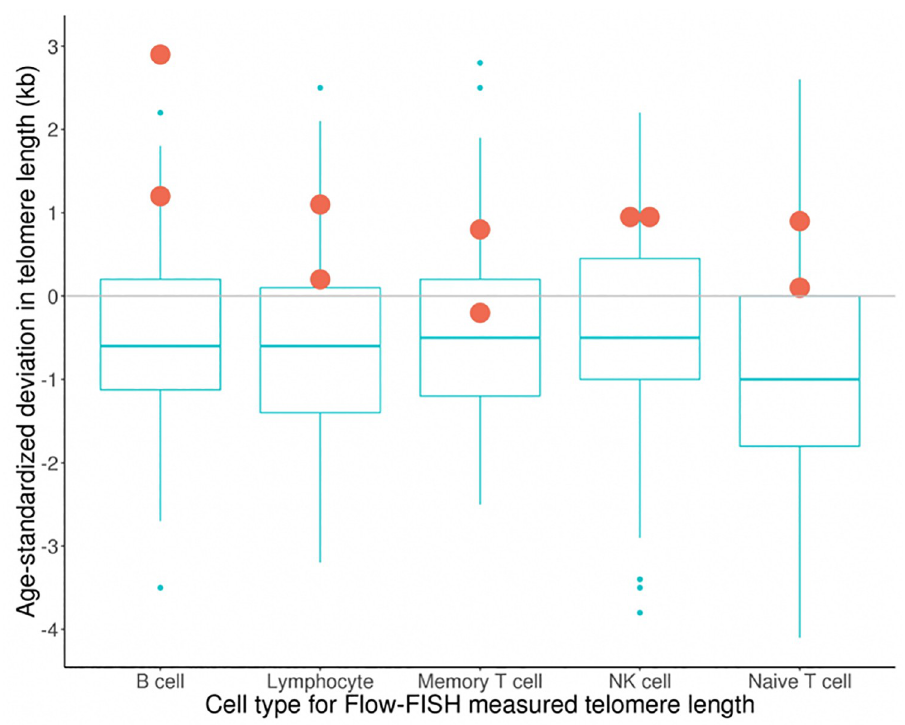
Fig 1. Deviation from the age-based mean leukocyte telomere length measured by flow-FISH in survivors of childhood cancer. Two of these survivors (one CEU and one YRI) were heterozygous for the high risk POT1 rs58722976-G allele (denoted by circles) and demonstrate telomere length that is above the median for all leukocyte subsets and significantly longer among B lymphocytes than telomere length in survivors who lack this variant. Boxes include values falling between the 25 th and 75 th percentile deviation in telomere length from the age-based mean.